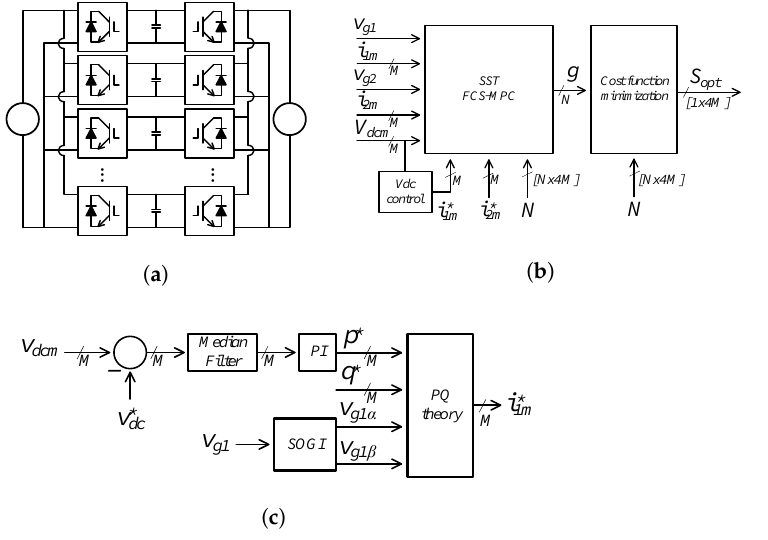
Figure 12. Generic M -modules IPOP CHB-B2B converter: ( a ) topology configuration, ( b ) MPC diagram block, ( c ) primary side currents reference